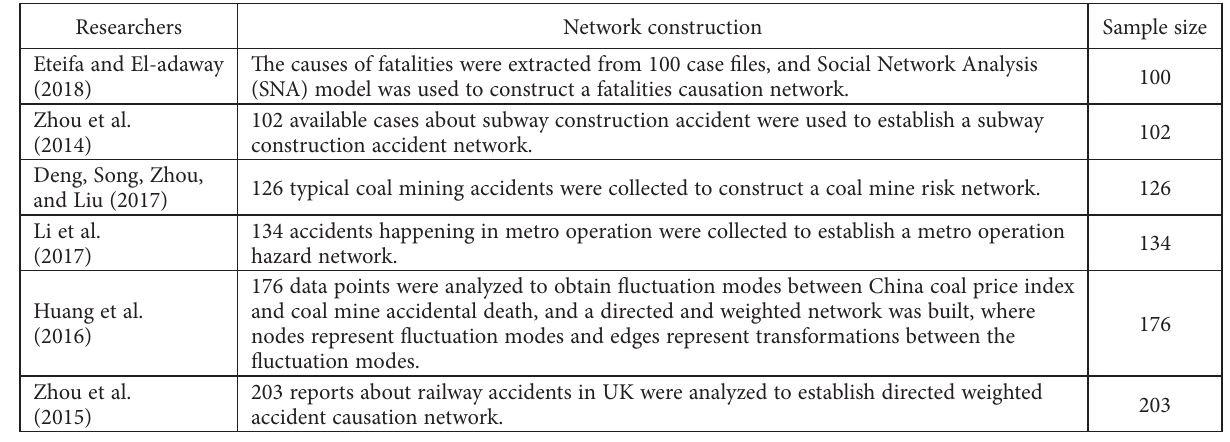
Table 1. Sample sizes in project management researches using complex network theory